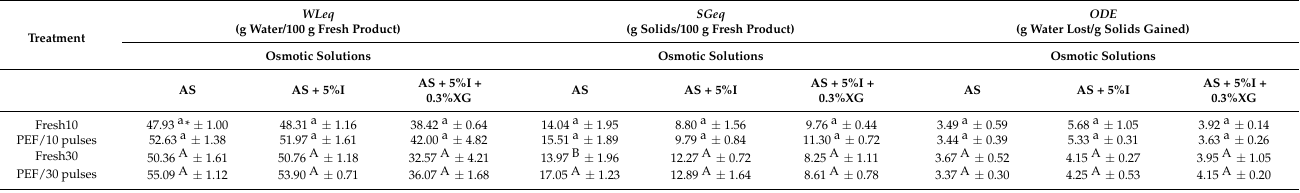
Table 3. Equilibrium and efficiency ratio of fresh and PEF treated mango during osmotic